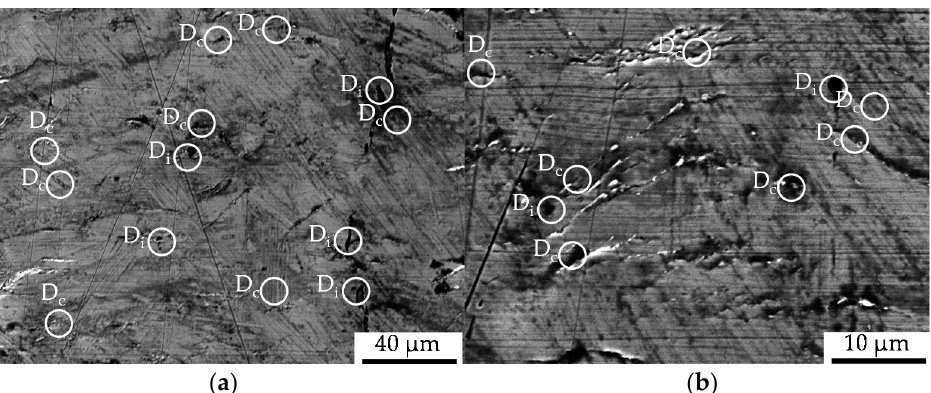
Figure 13. Cyclic damage (D c ) on the surface of the specimen induced under cyclic compression–tension load paths interacting with the initial damage (D i ): ( a ) initial interface decohesion of the metallic matrix and the MnS-inclusions identified after the intermittent testing at defined lifecycle phases interacting with shear bands; ( b ) decohesion of the initial interface matrix and the MnS-inclusions identified after intermittent testing at defined lifecycle phases interacting with intrusions and extrusions.